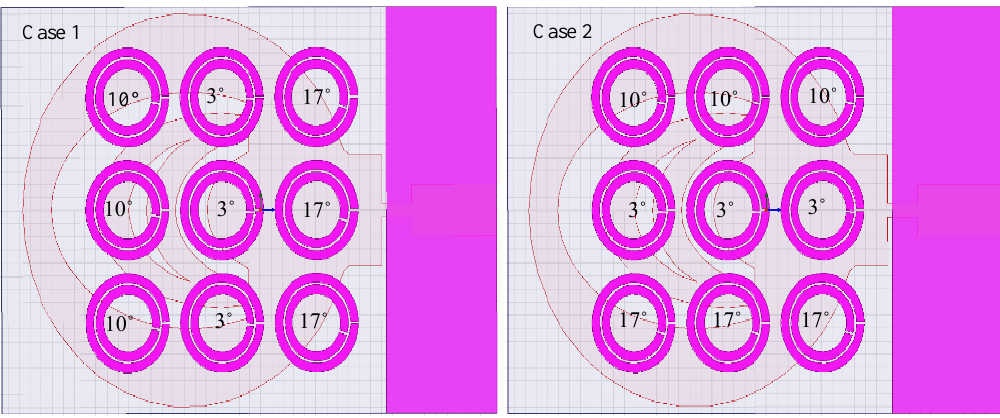
Figure 28. Inner ring rotation for C-SRRs.